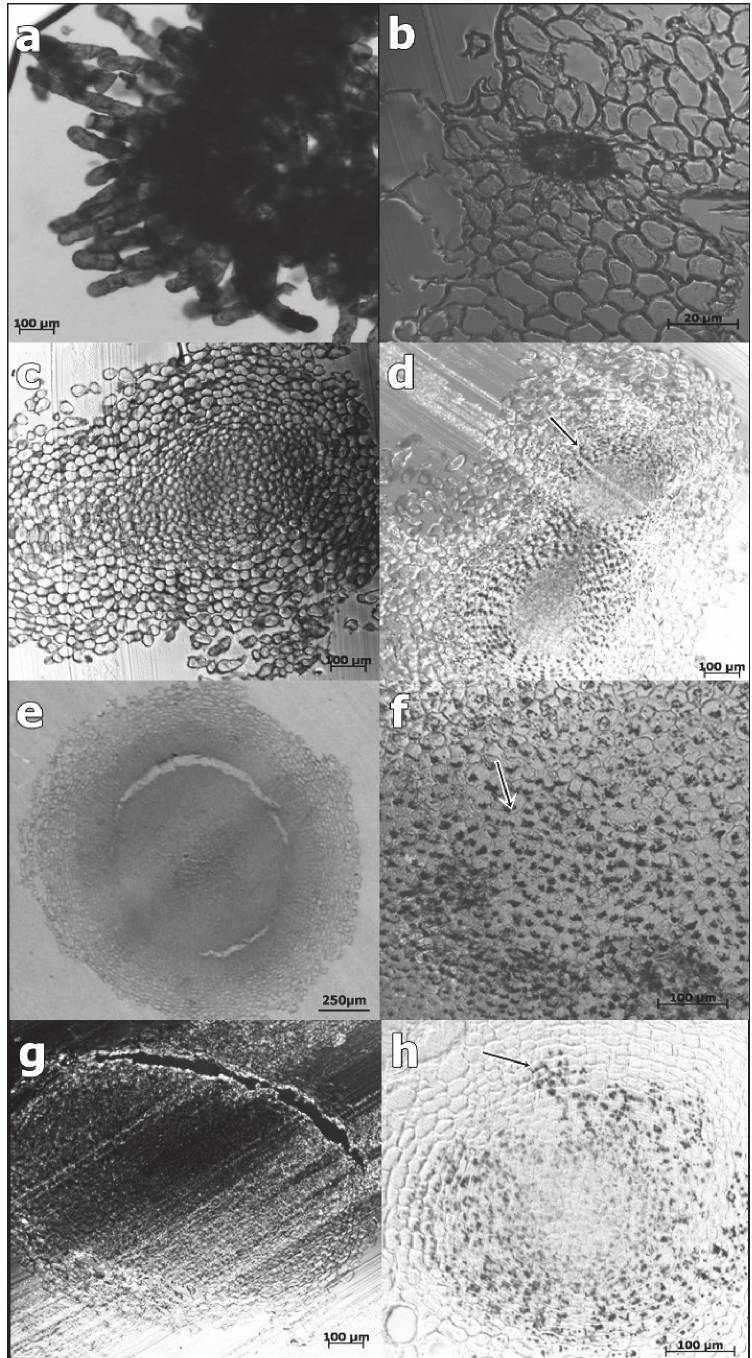
Figure 4 - Histochemical analysis of oil palm tenera hybrid ( Elaeis guineensis ) callus leaves induced with 2,4D and picloran A) Callus Type 1 stained with toluidine blue. Elongated and dispersed cells (arrows); B) Callus Type 1 stained with Lugol; C) Callus Type 2. Cells strongly stained with toluidine blue (arrows); D) Callus Type 2 stained with Lugol. Starch grains (arrows); E) Callus Type 3 stained with toluidine blue. Globular structure with procambium (Pc); F) Callus Type 3 with starch grains stained with lugol (arrows). G) Callus Type 4 stained with toluidine blue. Isodiametric small cell H) Callus Type 4. Starch grains stained with lugol.